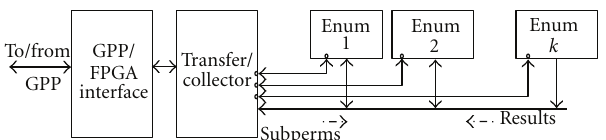
Figure 9: FPGA design. The transfer/collector (T/C) block receives a set of subpermutations from the GPP and schedules them among the various MPCA enumerators. Whenever an enumerator finds an MPCA it is sent back to the T/C and back to the GPP for